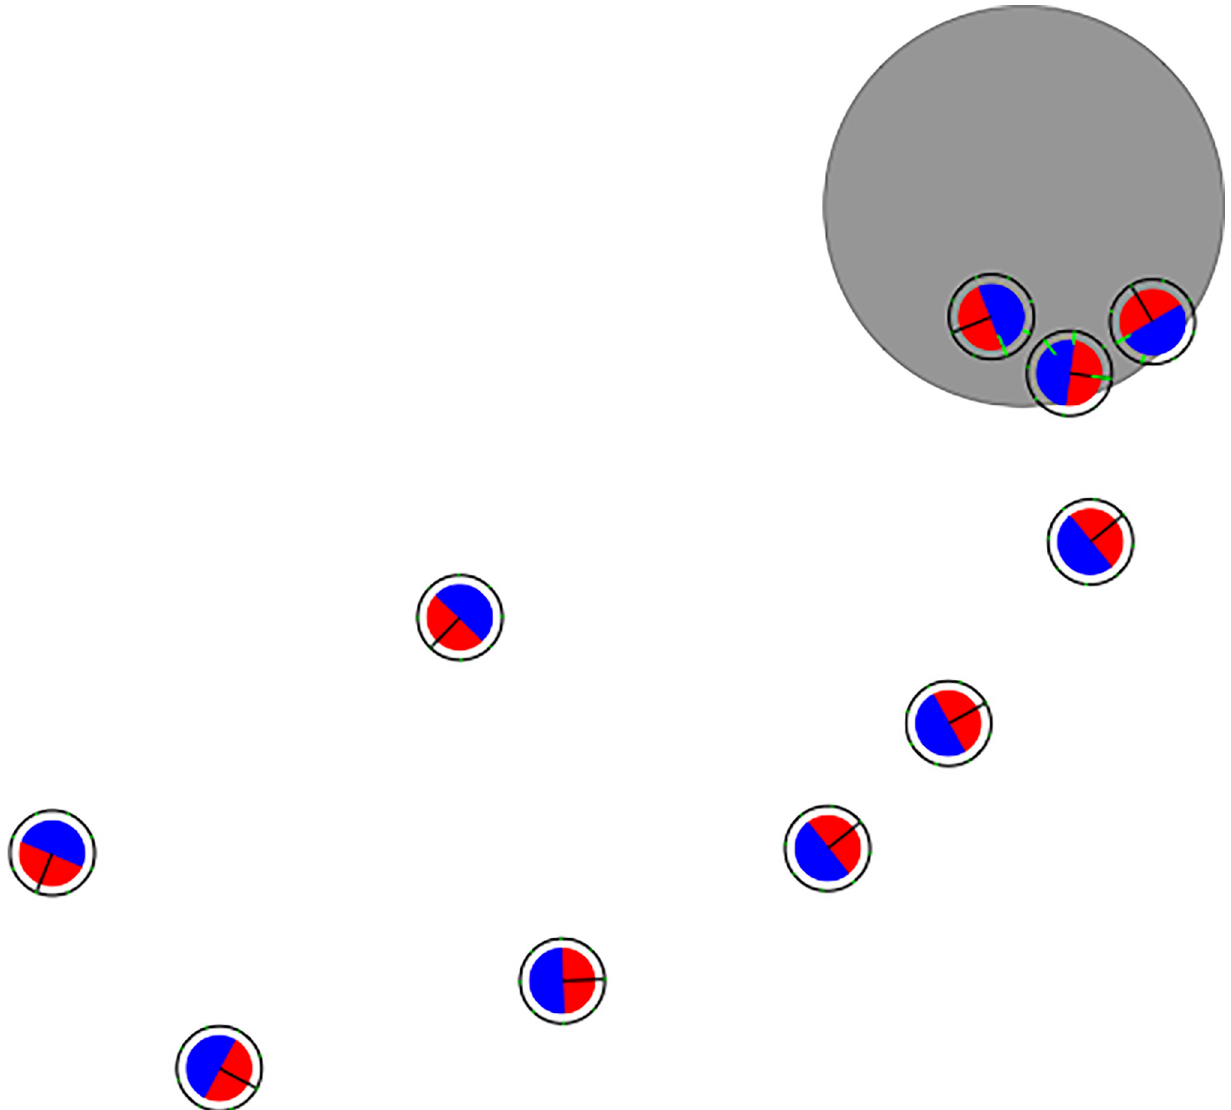
Fig 5. Top view of the environments and of the robots. The black lines and the gray circle represent the walls and the nest, respectively. The smaller circles represent the robots. The red and blue semicircles inside the robot indicate the red and blue LEDs located on the frontal and rear side of the robot.